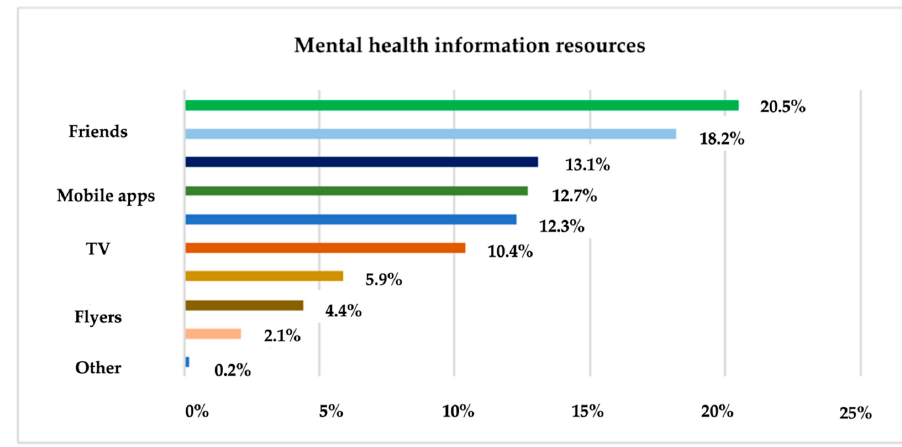
Figure 4. The sources used for mental health information.